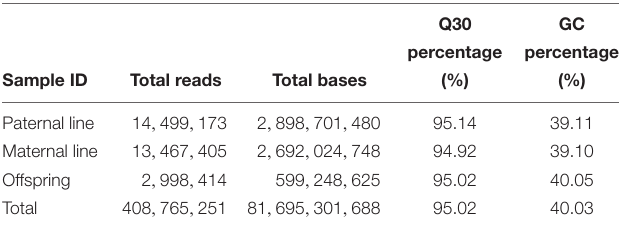
TABLE 1 | Specific locus amplified fragment sequencing raw data of a DH segregation population in broccoli.